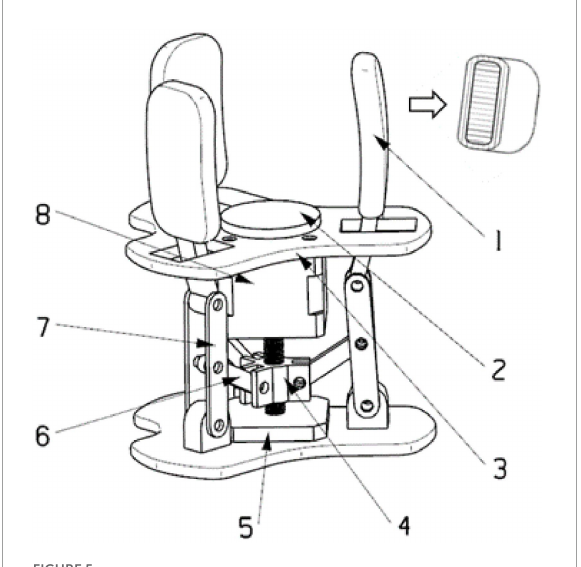
FIGURE5 Gripper structure design (1. Finger 2. Flexible finger pad 3. Limit flange 4. Slider 5. Support flange 6. Limit link 7. Support link 8. Screw